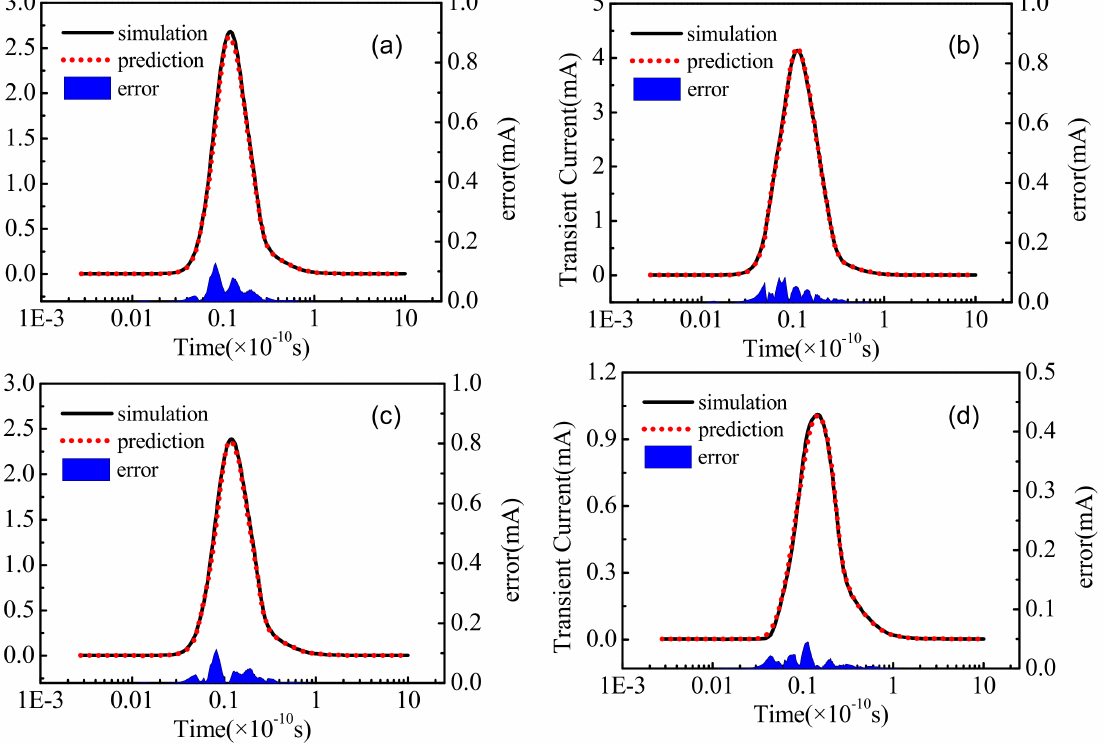
Figure 6. Comparison of simulation curve and prediction curve: ( a – d ) are the comparison results of the prediction curve and the simulation curve of four groups of transient current pulses randomly selected from the test set. The blue area in the figure is the difference between the